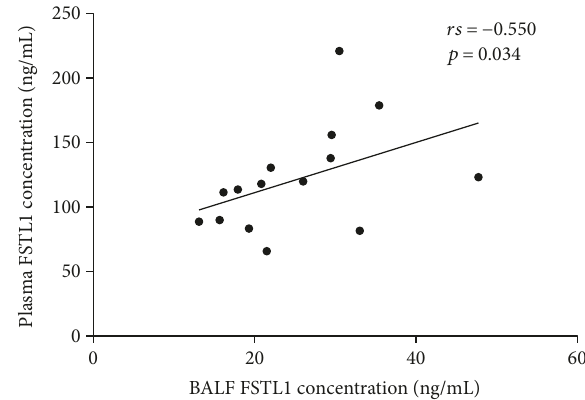
Figure 3: Correlation between FSTL1 levels in plasma and BALF. Correlation was determined by Spearman rank correlation